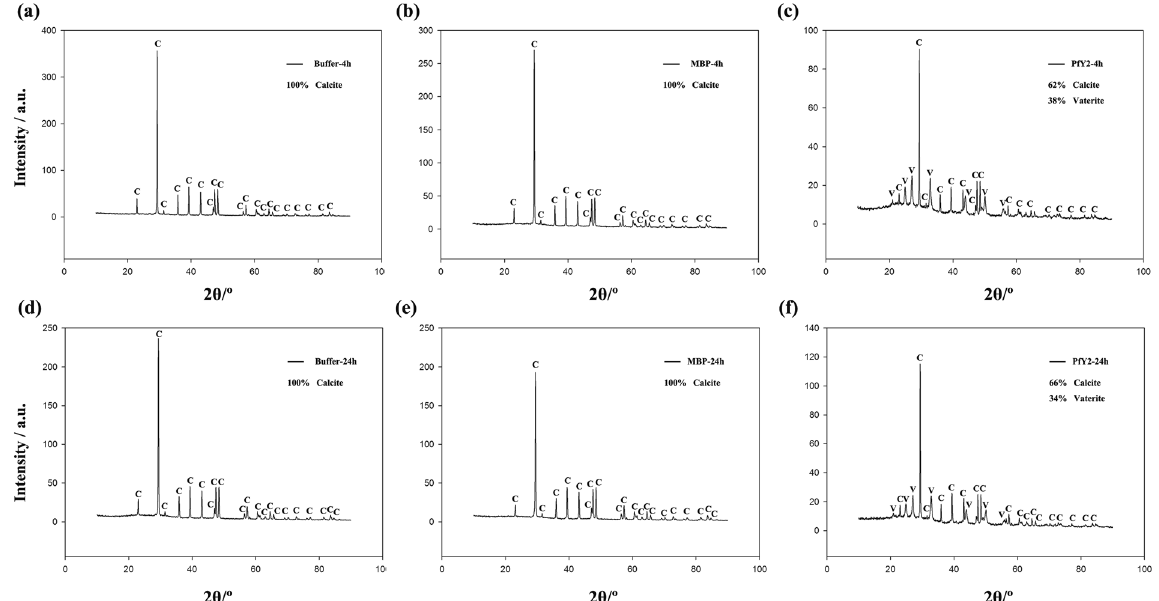
Figure 10. The effects of rPfY2 on ACC transition to calcite. XRD was performed to detect the percentage of the crystals ACC transformed to. The final concentration of rPfY2 was 50 μ g/ml. Equivalent of MBP was added to the reaction system as control.